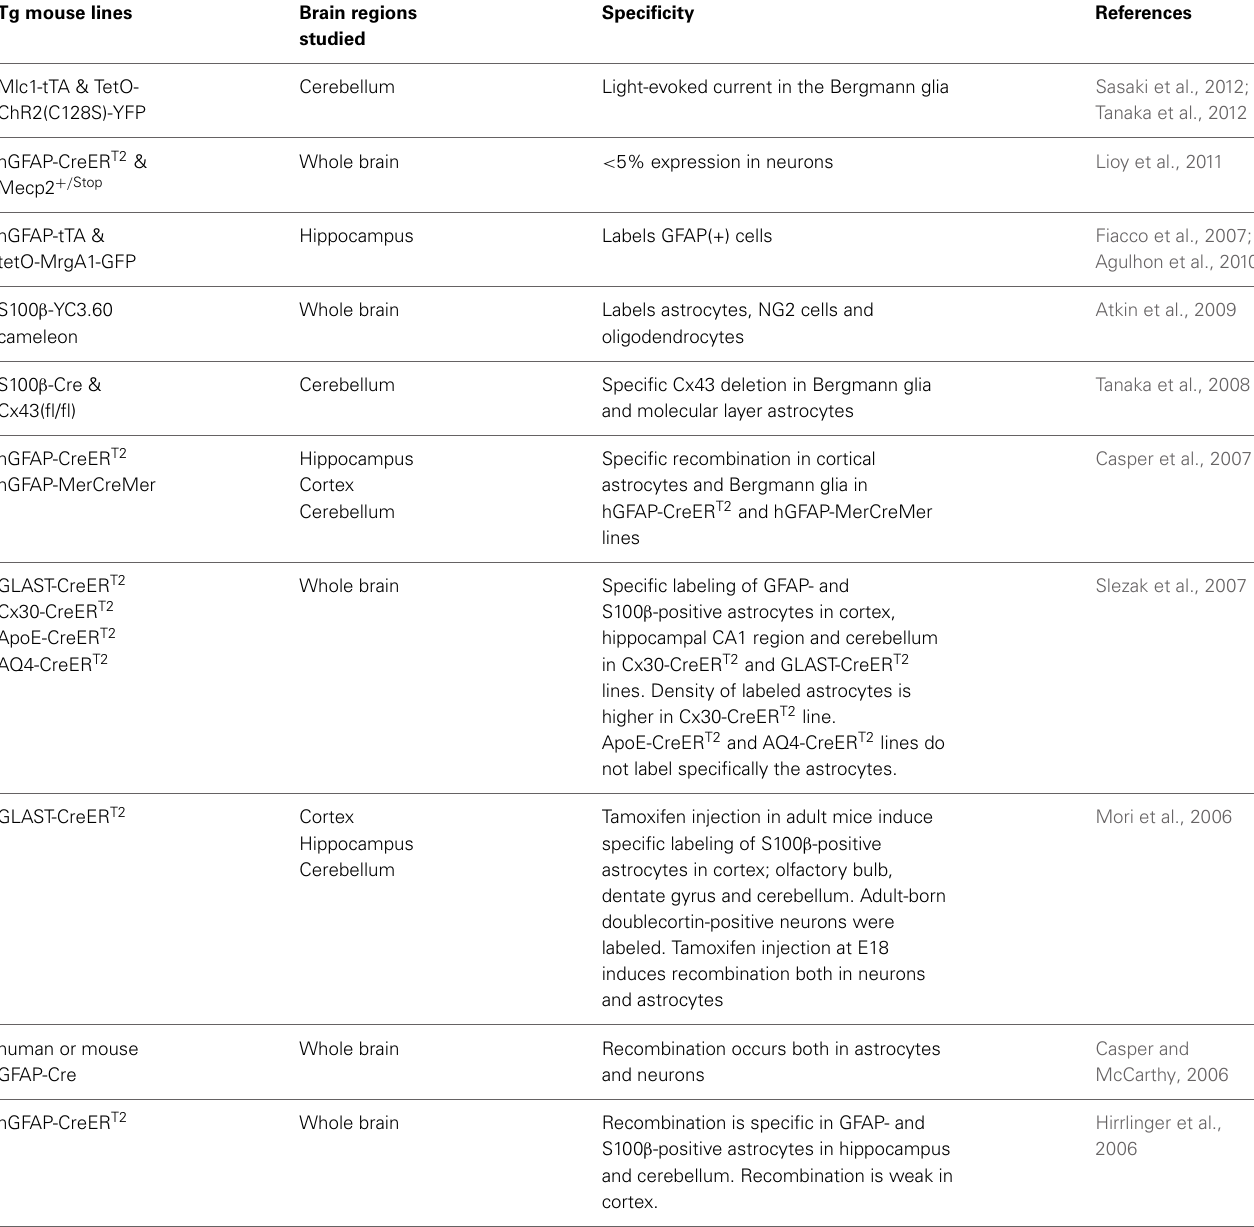
Table 2 | Transgenic (Tg) mouse lines for specifically targeting mouse